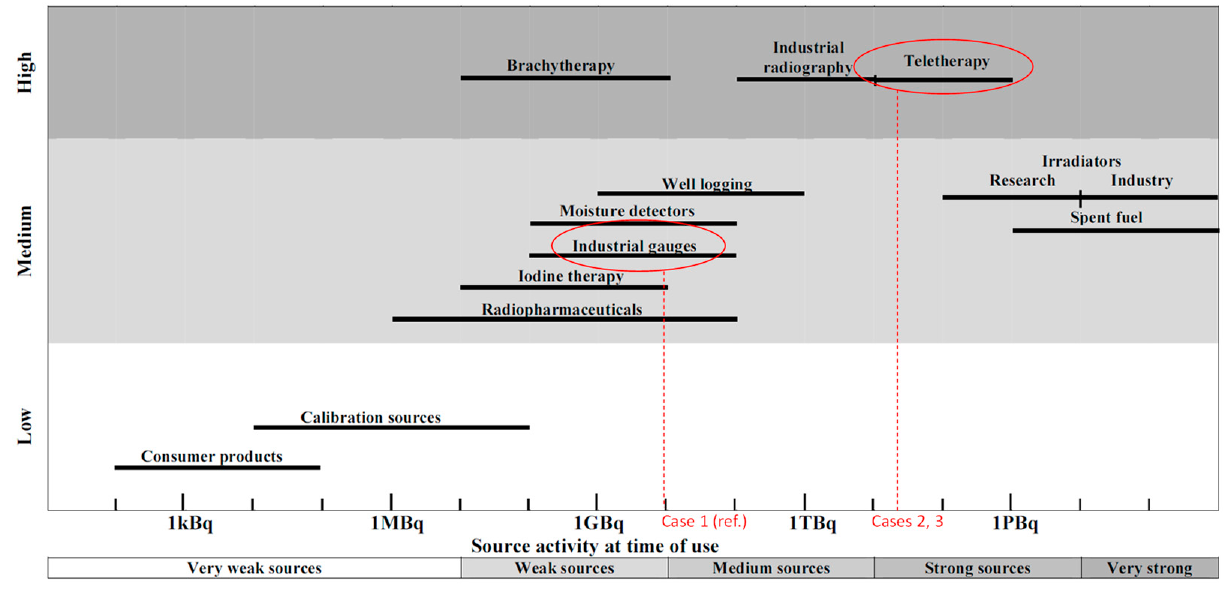
Figure 1. A classification that compares the severity and complexity of the different incidents as a function of the activity. This figure is readapted from IAEA 1162 [2].